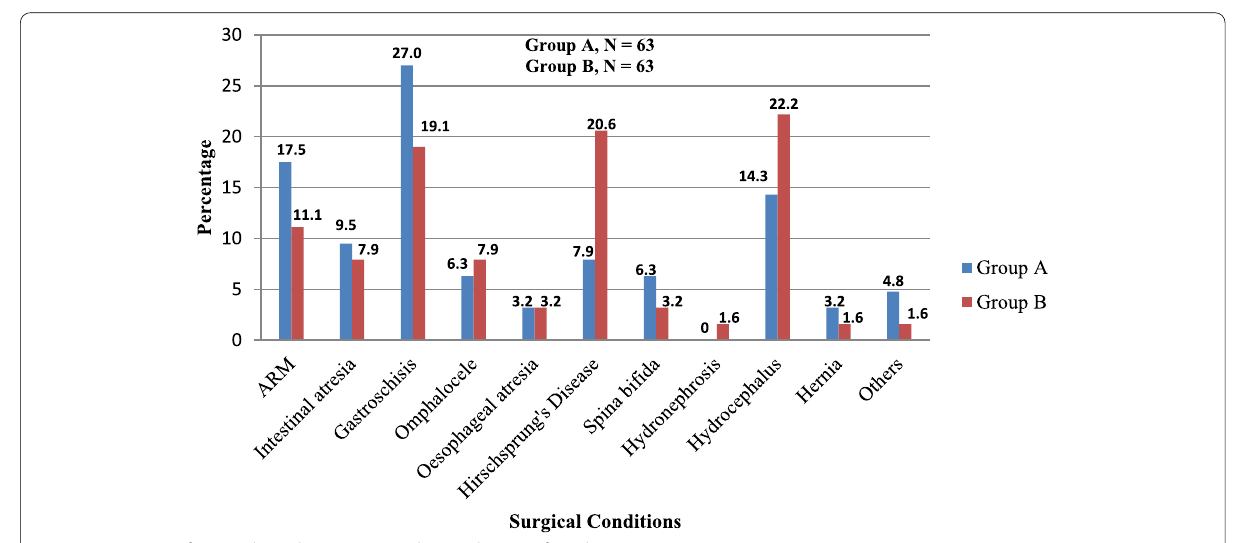
Fig. 1 Spectrum of surgical conditions seen in the newborns referred to